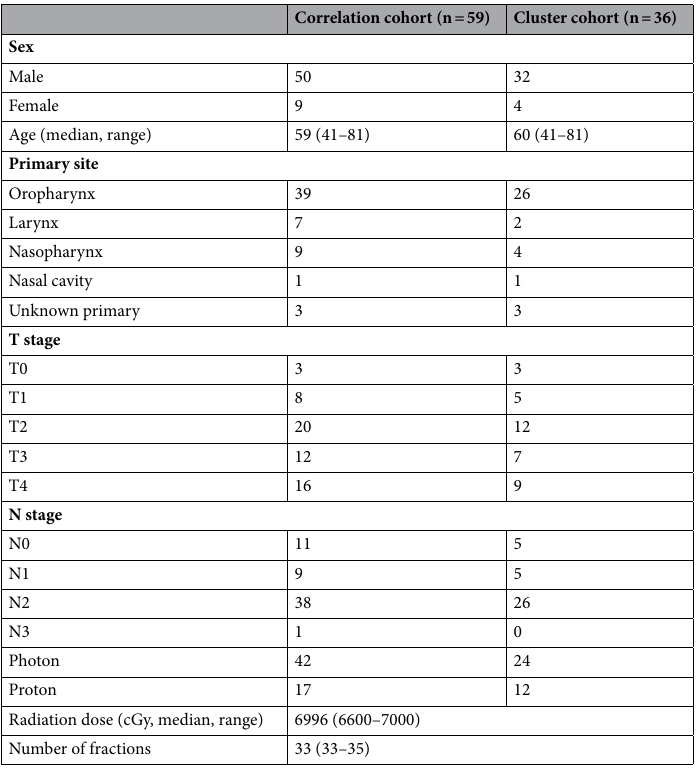
Table 1. Patient